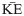
Comparison of (a) kinetic energy density (KE¯), and (b) the rate of viscous dissipation per unit volume (Φ¯) during the cardiac cycle, between the wild type zebrafish and in response to chemical (AG1478) and genetic (gata1aMO, wea) treatments.